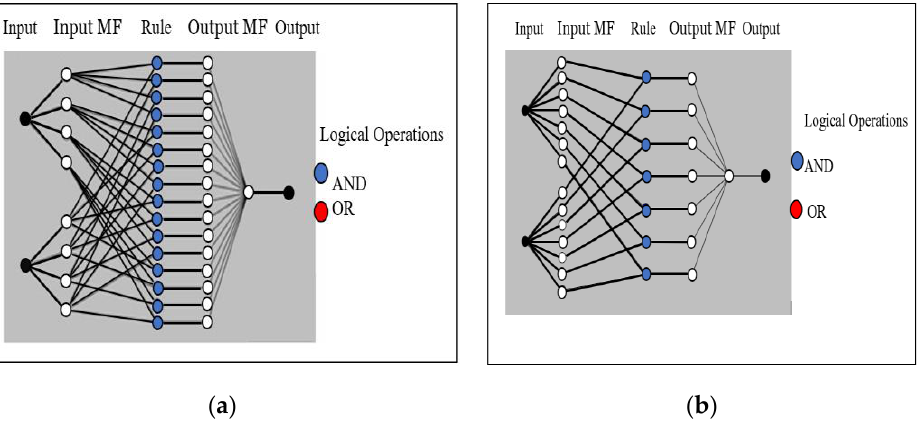
Figure 10. ( a ) ANFIS model architecture for overcrowding risk level prediction where the branches show the characteristics of the ANFIS model structure beside the feed-forward network; ( b ) ANFIS network after applying subtractive clustering.